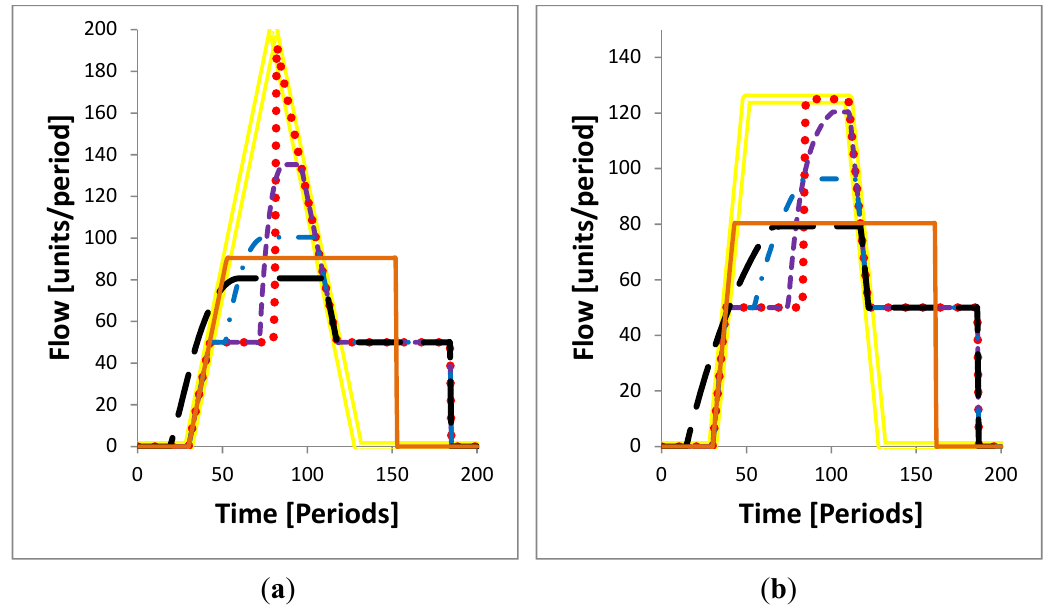
Figure 12. Effect Forecast Period on Operation using the SFPM Rule for ( a ) Triangular Hydrograph and ( b ) Broad Peak